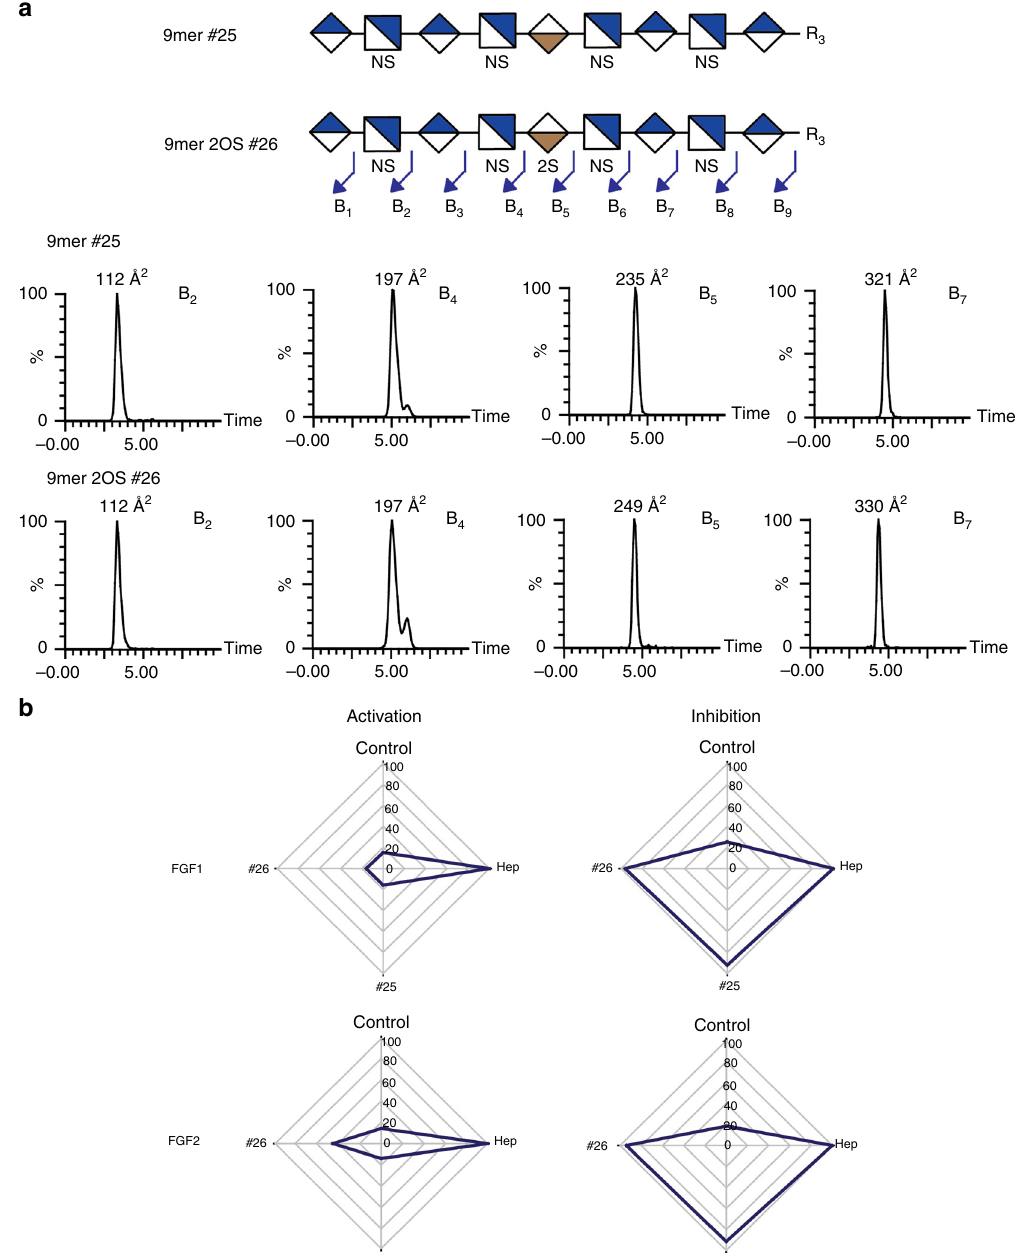
Fig. 4 MS 2 sequencing of two 9mer saccharides. HS structures #25 and #26 were fragmented in the trap and separated through IMMS to create a de fi ned set of CCS values for each fragment. IMMS of fragments ( a ) represent B ion fragments from #25 , and #26 , indicating that the 2 O -sulfate is on the IdoA at position 5. Fragment ions from B/Y/C/Z are displayed in Supplementary Tables 15 and 16. b Radar chart illustration of BaF3 cell activation and inhibition assays of HS structures #25 and #26 . Activation (cell proliferation) assays were performed with fi broblast growth factor 1 (FGF1) or FGF2 (1 ng/mL) and standards #25/26 . Heparin (3 μ g/mL) was used as positive control, while FGF1 or FGF2 alone was used as negative control. Inhibition assays were performed with the same compounds (3 μ g/mL) in the presence of a sub-maximal dose of heparin (0.1 μ g/mL). Cell proliferation results were expressed as a percentage of heparin activity set as 100%. Data for panel b are presented as mean ± standard deviation, n = 3. Source data are provided as a Source Data fi